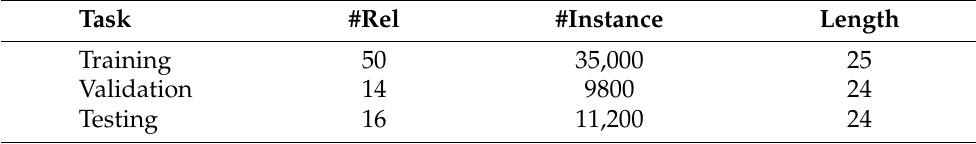
Table 1. Statistics of FewRel. “#Rel” and “#Instance” denote the number of relations and instances, respectively. “Length” means the average token length of instances.